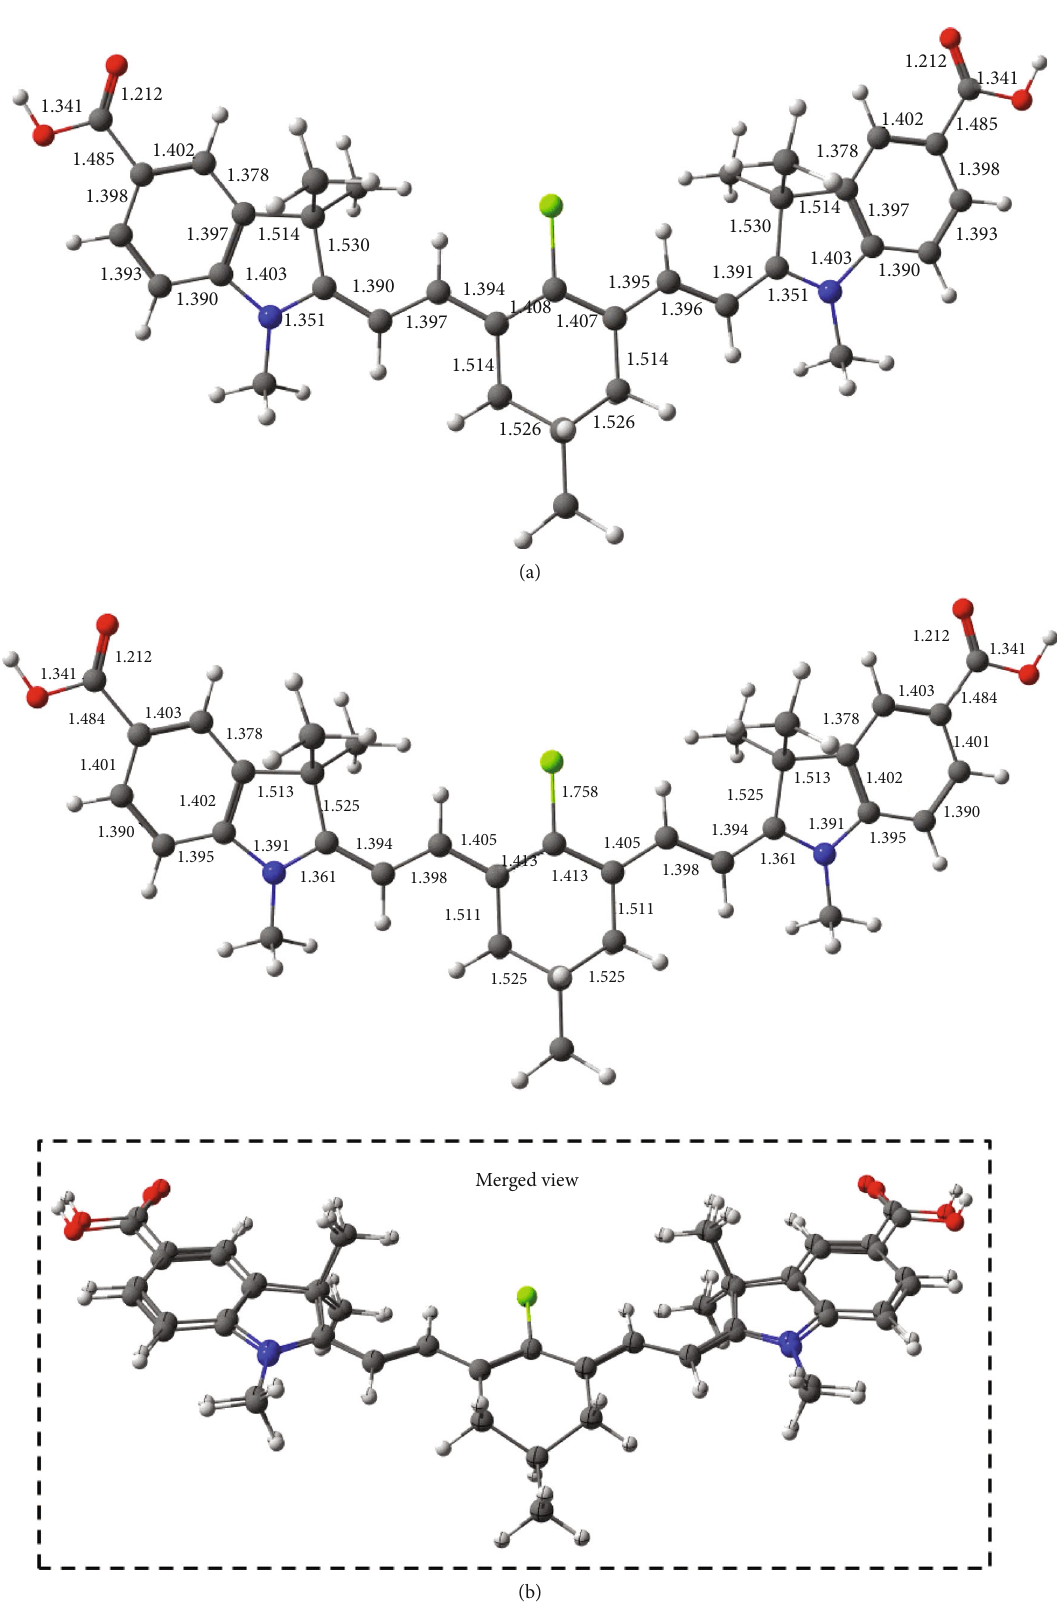
Figure 6: Optimized geometries for the (a) ground and (b) fi rst excited states of cyanine 13 in PCM/methanol. A merged view (S presented for